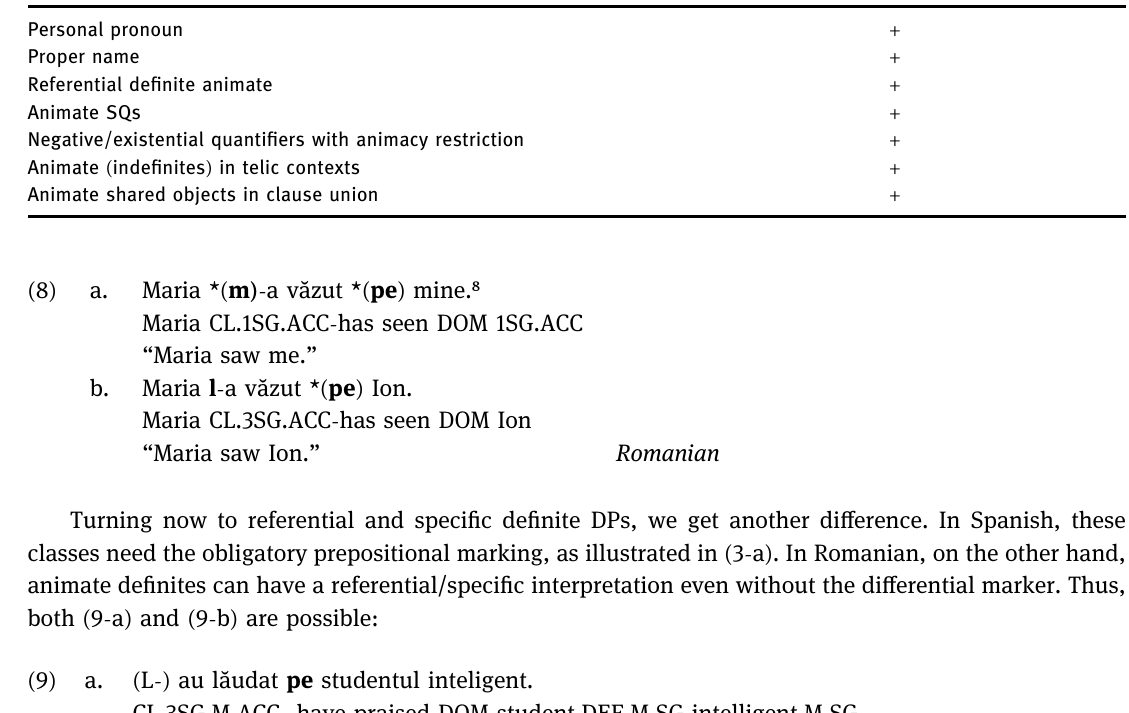
Table 1: Obligatory DOM – standard Spanish animates ( preliminary )